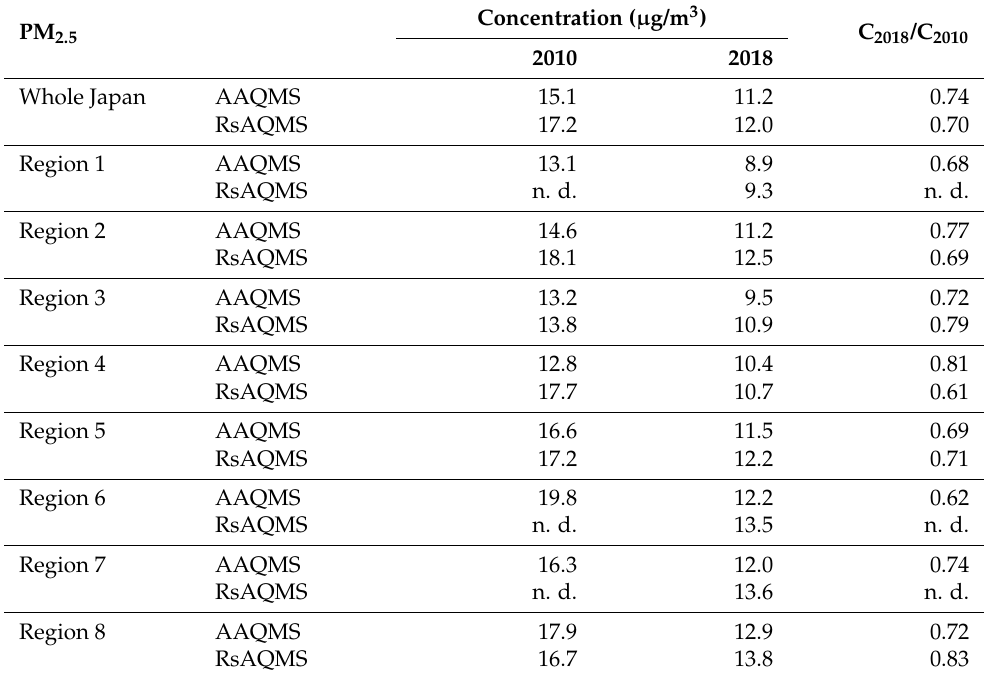
Table 2. National and regional PM 2.5 mass concentrations (2010, 2018) and their concentration ratios. PM